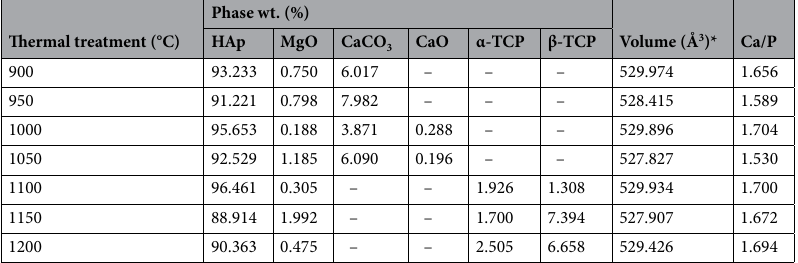
Table 1. Structural parameters obtained for the samples from XRD patterns by Rietveld refinement. *Stoichimetry cell volume = 527.52 Å 3 .